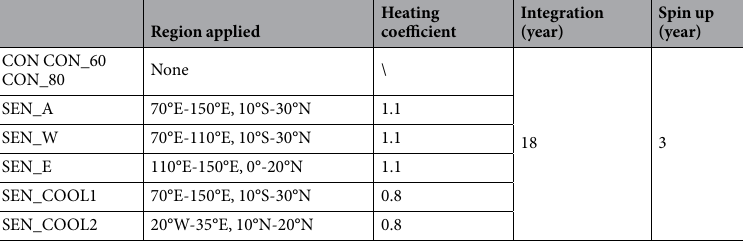
Table 1. List of model experiments and experiment designs.